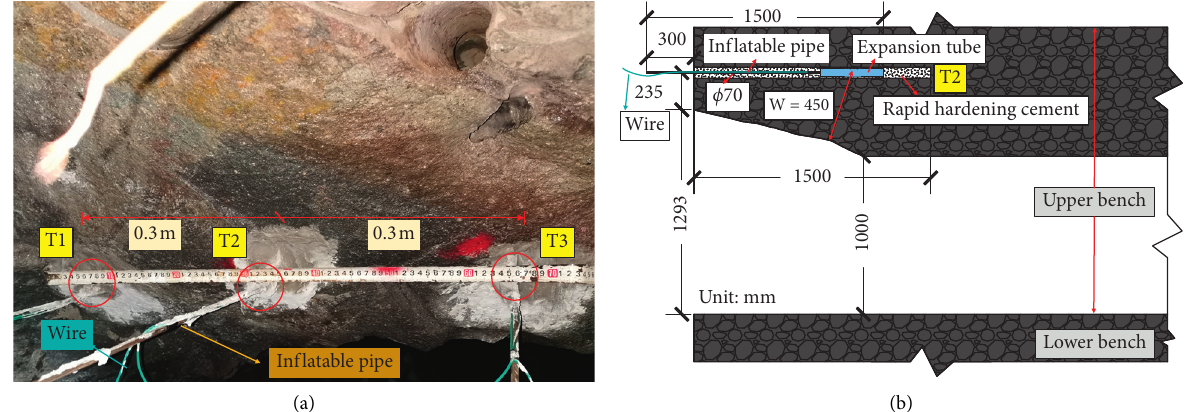
Figure 8: Arrangement of rock fracturing points on vault. (a) Actual arrangement; (b) profile.